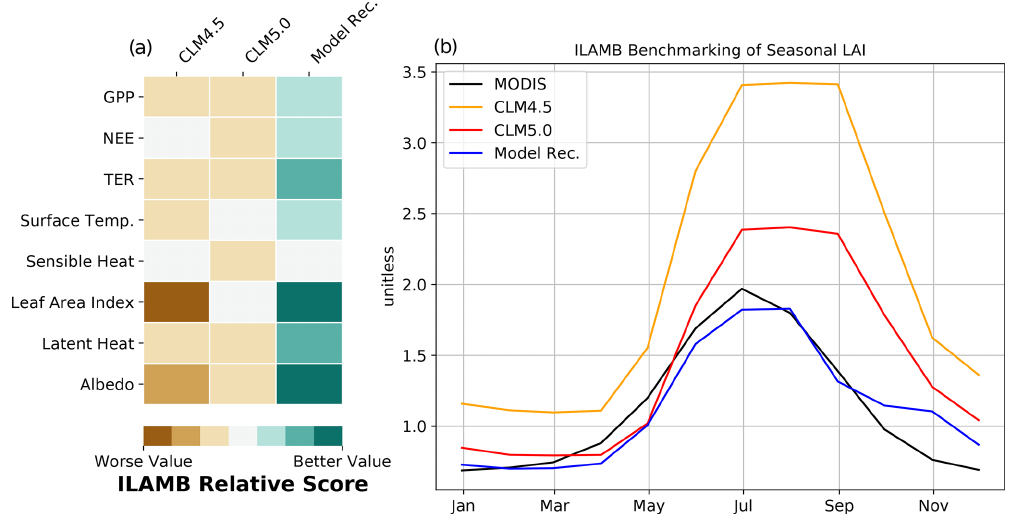
Figure 5. ILAMB benchmark score of CLM5.0 model development recommendation against previous versions of CLM: 5.0 and 4.5 (a) . LAI seasonal results compared to MODIS (b) .